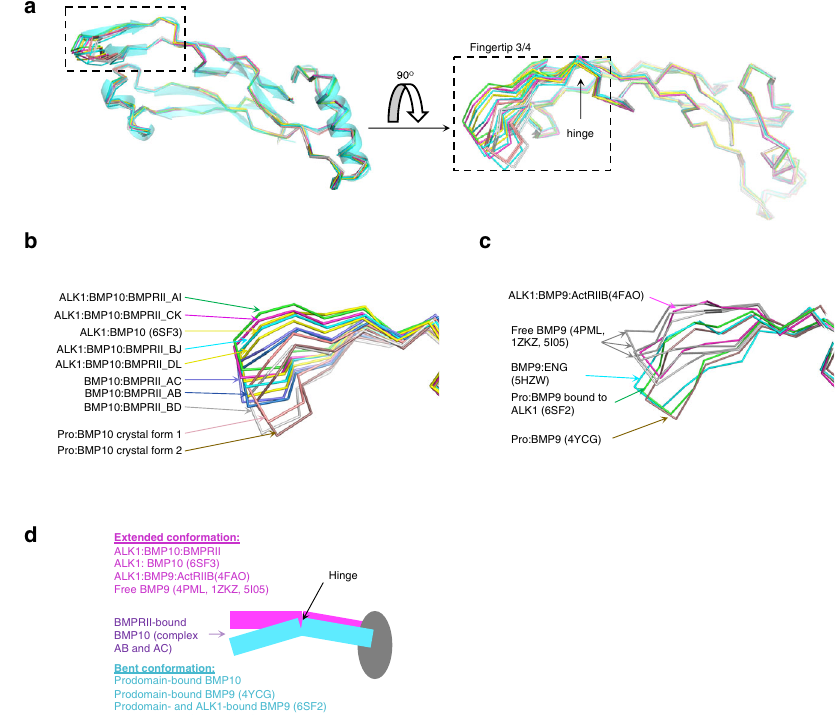
Fig. 6 Context-dependent fi ngertip 3/4 conformation in BMP9 and BMP10. a An overlay of all BMP10 monomers from different protein interaction contexts. Sources of structures are listed in Supplementary Table 5. b A close-up view of fi ngertip 3/4 with all the structures annotated. c A closed-up view of fi ngertip 3/4 region after superposition of all BMP9 monomers from different protein interaction contexts. Sources of the structures are listed in Supplementary Table 5. The overlay of the full monomers can be found in Supplementary Fig 9. d A schematic diagram depicting the context-dependent conformation of fi ngertip 3/4 in BMP9 and